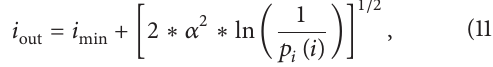
Input image is first decomposed into three channels (red, green, and blue). Then histogram stretching is performed on individual channels. With the assumption that each of R, G, and B channel is Rayleigh distributed, histogram stretching is done with respect to Rayleigh distribution. The scale parameter is estimated from given image. So the histogram stretching is adaptive. The scale parameter (𝜃) is estimated using the maximum likelihood method given below. First find log likelihood function of image as given